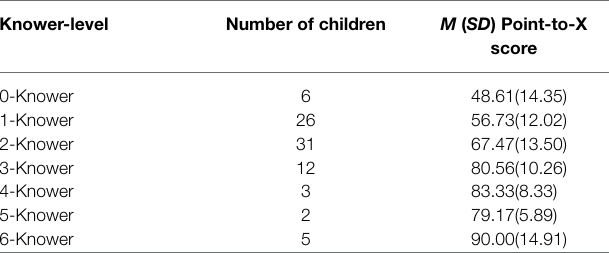
TABLE 3 | Descriptive statistics for children’s performance in the Give-N task, N = 85. Knower-level